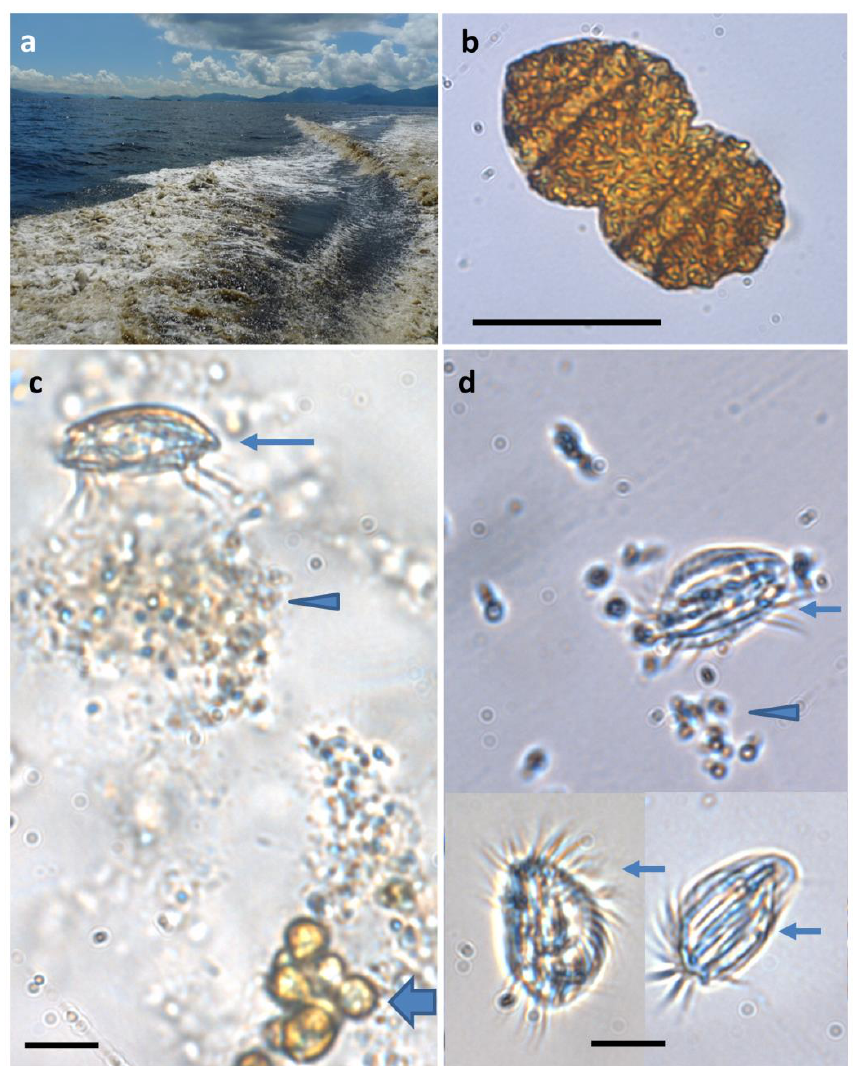
Figure 2. Bloom, Polykrikos geminatum , and ciliate cells. ( a ) Photograph of brown water in the Pearl River Estuary in P. geminatum bloom. Photomicrographs of a ( b ) P. geminatum dual-cell colony fixed in Utermöhl’s solution, ( c ) ciliate cells (thin arrow) and P. geminatum cells (thicker arrow) and detritus (arrow head), and ( d ) ciliate cell apical and antapical views (thin arrow) and P. geminatum cell detritus (arrow head). Scale bars ( b – d ) = 20 µm.